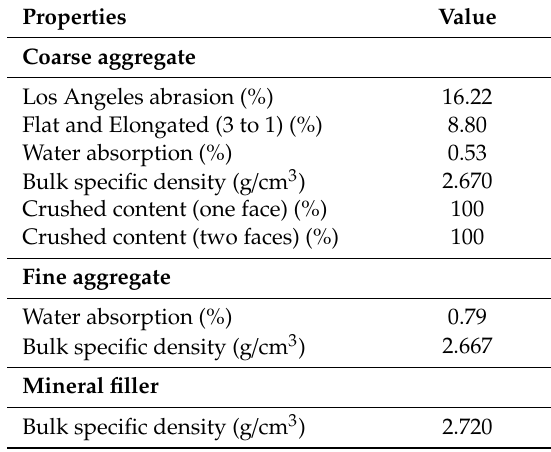
Table 1. Physical properties of coarse, fine aggregates and mineral filler.